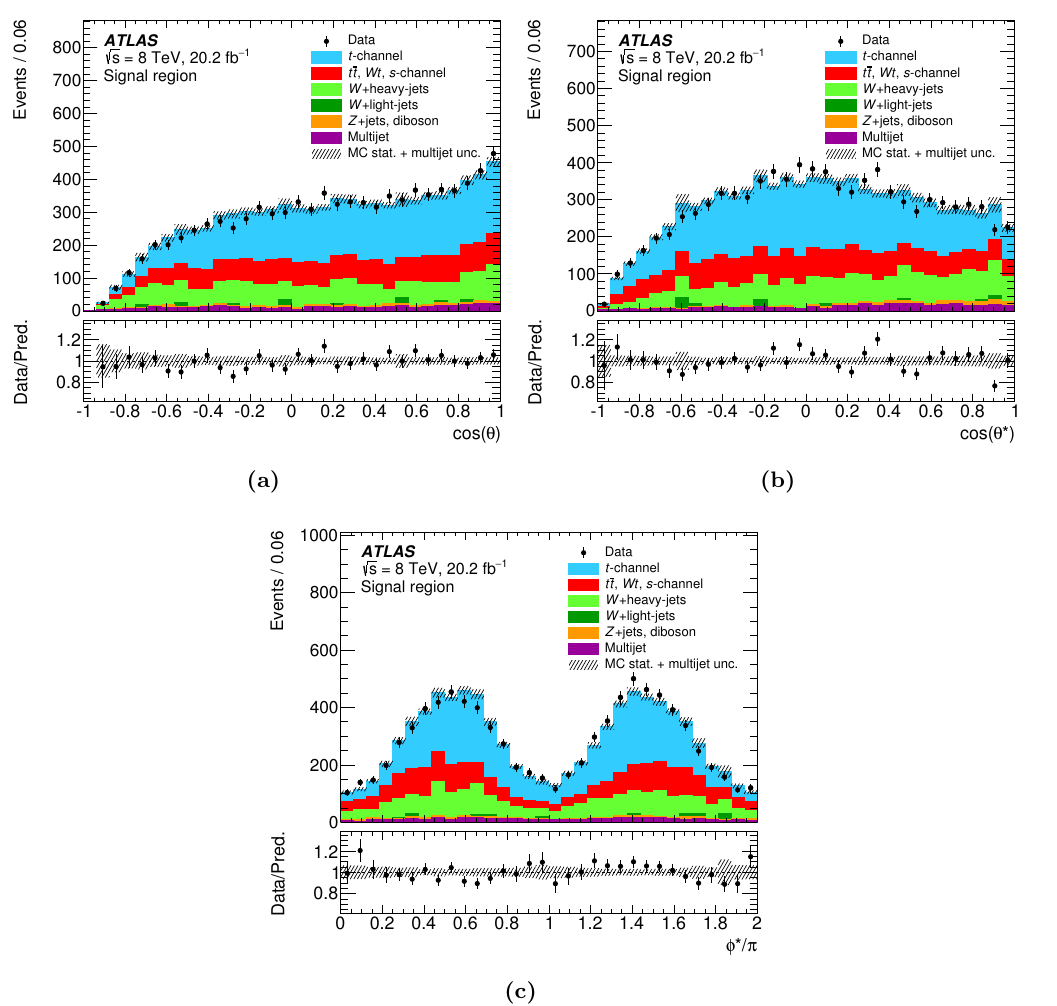
Figure 7. Angular distributions of (a) cos (cid:18) , (b) cos (cid:18) * and (c) (cid:30) * in the signal region for the electron and muon channels merged, comparing observed data, shown as the black points with statistical uncertainties, to SM signal and background predictions. The multijet background is estimated using data-driven techniques, while contributions from simulated W +jets, top-quark backgrounds and t -channel event samples are normalised to the results of a maximum-likelihood (cid:12)t to event yields in the signal and control regions. The uncertainty bands correspond to the uncertainties due to the size of the simulated event samples added in quadrature with the data-driven normalisation uncertainty of 70% estimated for the multijet contribution. The lower plots show the ratio of data to prediction in each